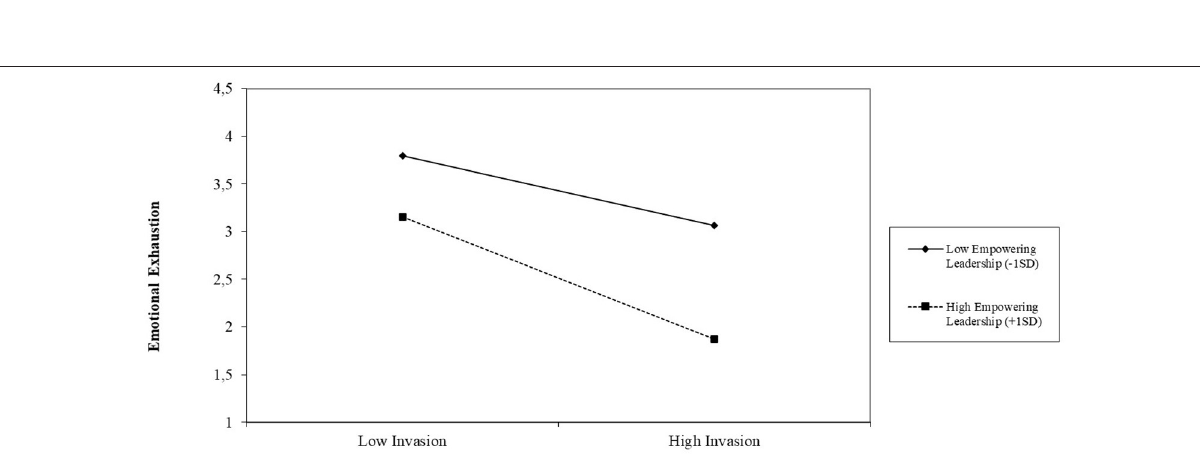
FIGURE 2 | Interaction plot for the relation between techno-invasion and emotional exhaustion under high ( + 1SD) and low ( − 1SD) empowering leadership.